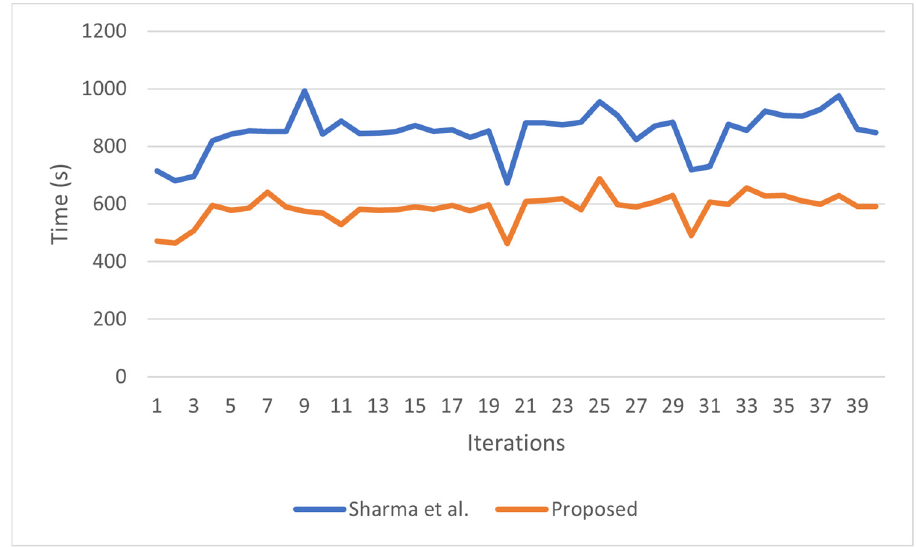
Figure 22. Runtime of our proposed method compared to Sharma et al. [7]